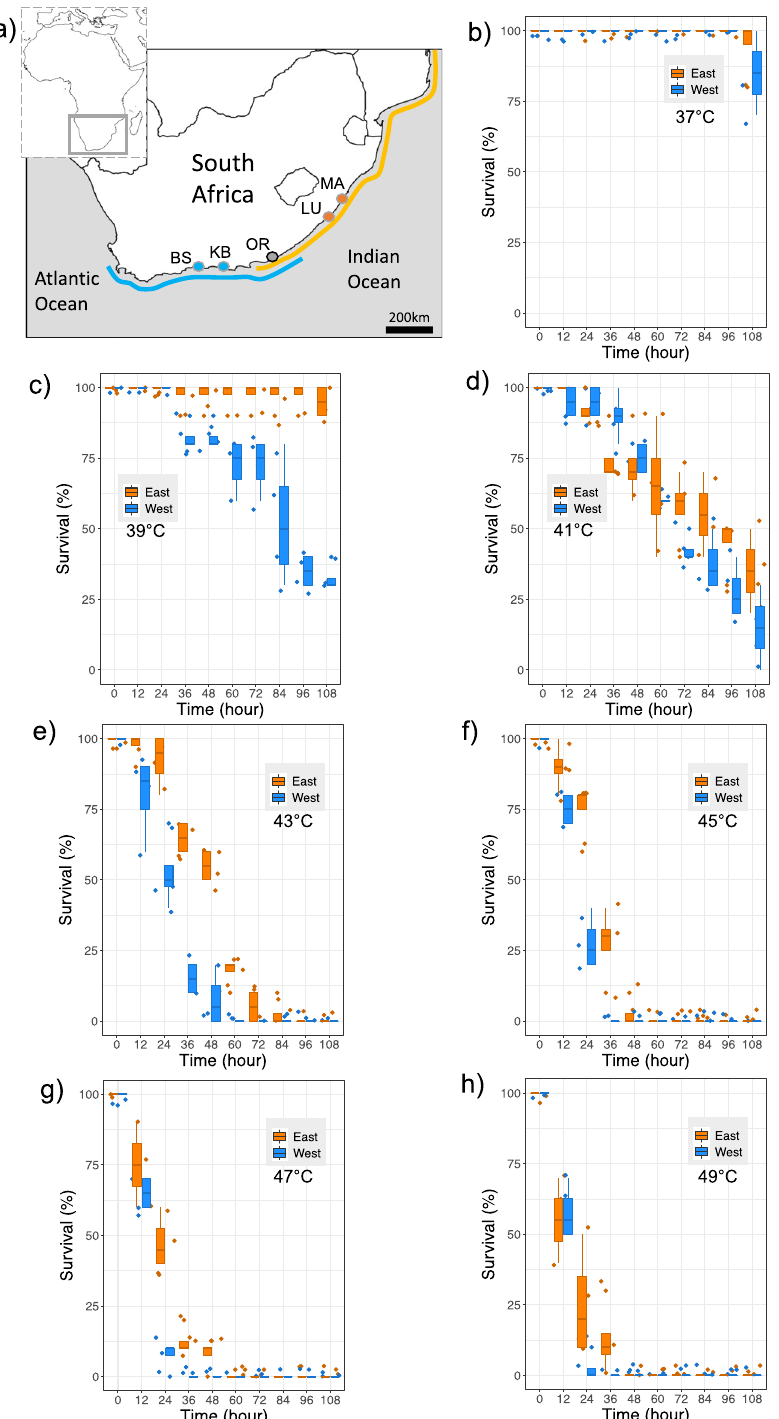
Figure 1. Map and survival rates in air. ( a ) Map showing the collection sites and the distribution of Perna perna genetic lineages in South Africa 20 . Survival rates in air at ( b ) 37 °C, ( c ) 39 °C, ( d ) 41 °C, ( e ) 43 °C, ( f ) 45 °C, ( g ) Fig. S1). Maps were generated using SimpleMapp (https:// www. simpl emappr. net/#